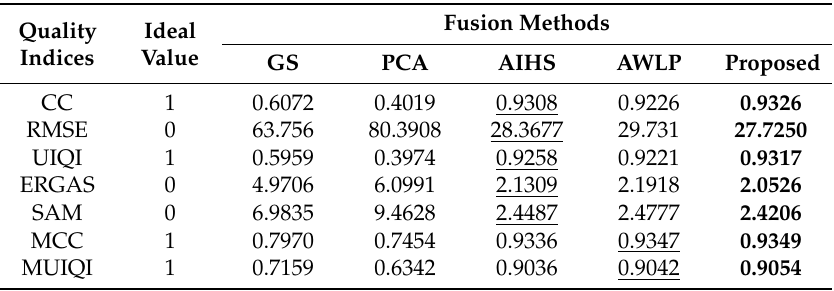
Table 4. Quantitative evaluation results of the GF-1 experiment (the best result is marked in bold, and the second-best result is underlined).